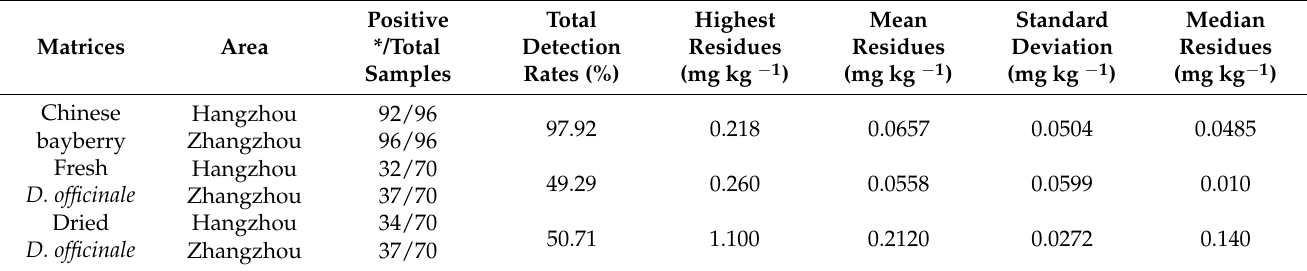
Table 3. Metalaxyl residues, incidences of occurrence, highest, mean and median residues in Chinese bayberry and fresh and dried D. officinale from Hangzhou and